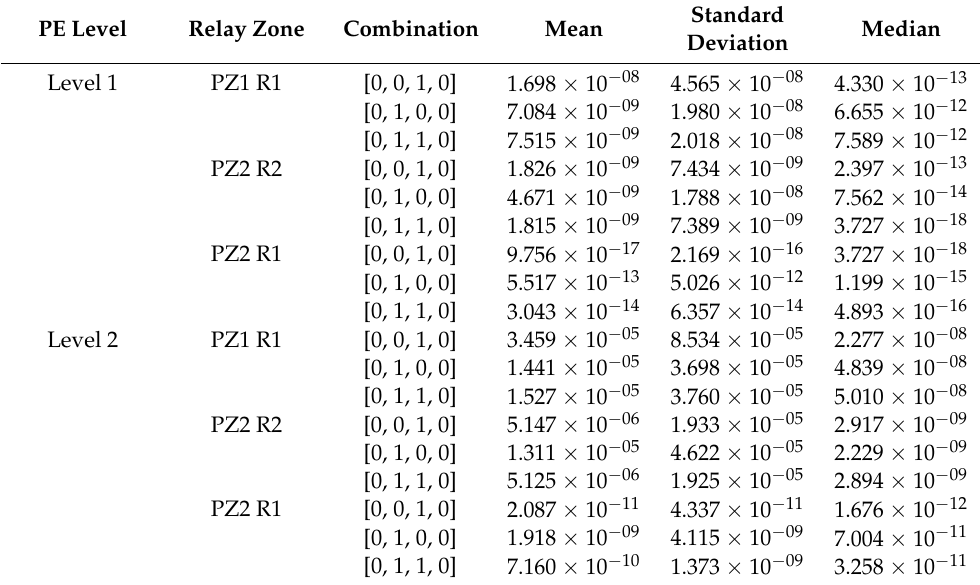
Table A2. PE values